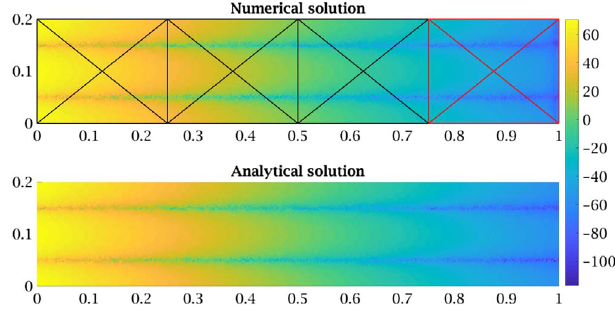
Figure 7. Pressure fi eld (dB) for n = 2 at 1500 Hz with C =